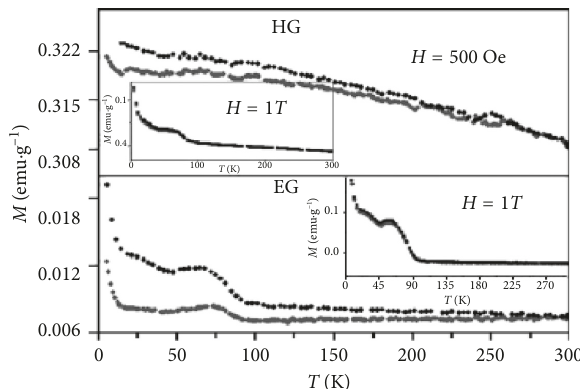
Figure 8: Temperature variation of magnetization of few-layer graphene.